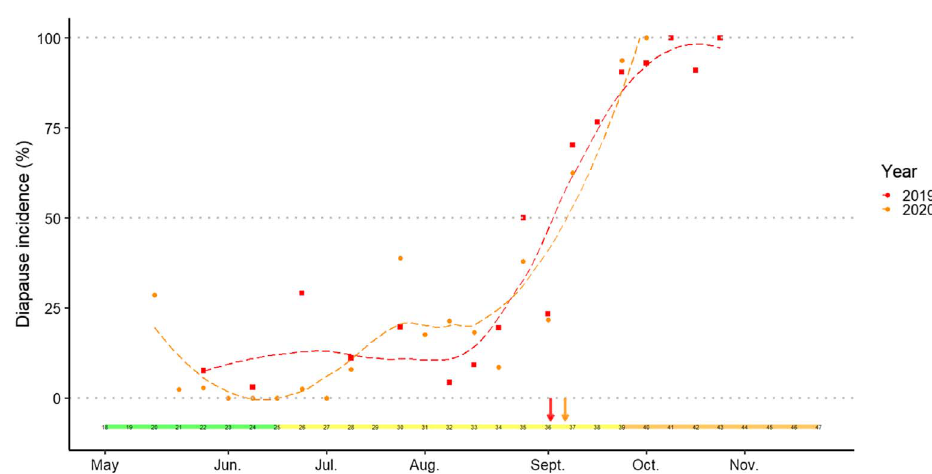
Figure 4. Diapause incidence in Ae. japonicus eggs. Mean diapause incidence per week observed from eggs collected in the Reichstett fi eld area. Data for 2019 are shown in empty red triangles while data for 2020 are shown in full orange triangles. Diapause incidence is achieved after hatching tests and bleaching treatment. The curve with dashed lines is the tendency of diapause incidence. A 50% diapause incidence observed in eggs, in dotted grey line, is achieved at week 36 for 2019 (red arrow) and week 37 for 2020 (orange arrow). Corresponding months and seasons are also shown in the coloured horizontal bar (green = spring, yellow = summer, orange =